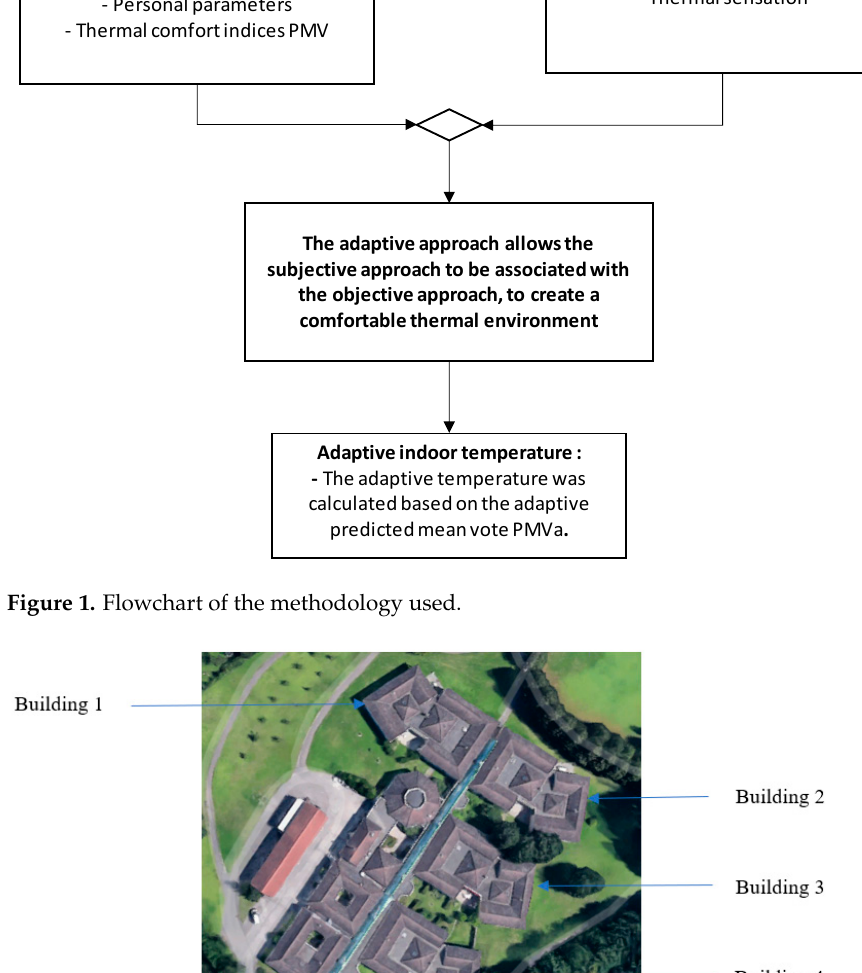
Figure 3. Surveyed building. Table 1. Population sex distribution. Women